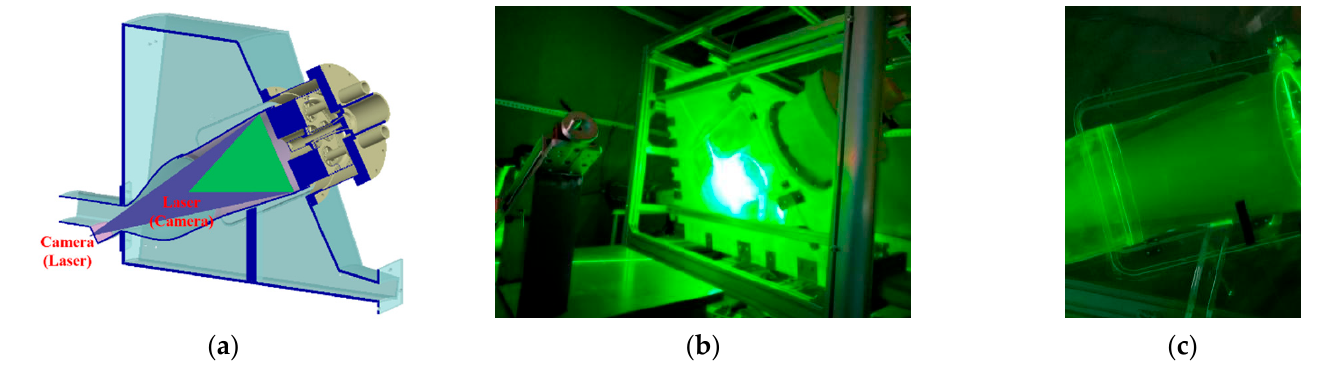
Figure 3. Optical scheme. ( a ) Location of camera and laser; ( b ) Cross section; ( c ) Longitudinal sec- tion.